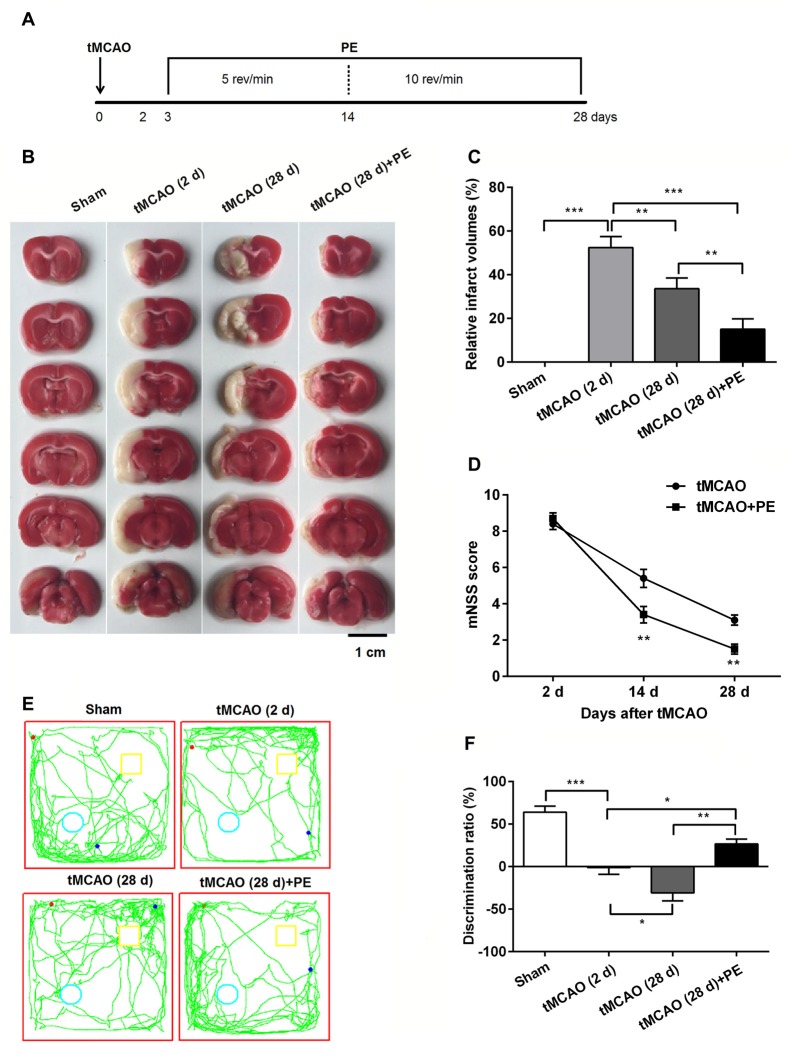
Physical exercise (PE) improves novel object recognition (NOR) memory in transient middle cerebral artery occlusion (tMCAO) rats. (A) Spontaneously hypertensive rats (SHR) were subjected to tMCAO or sham surgery, followed by 26 days of PE starting on day 3 post-tMCAO. Thereafter, infarct volumes were (B) imaged and (C) measured n = 5; (D) neurobehavioral outcomes were evaluated based on modified neurological severity scores (mNSS) n = 20; (E) Exploration patterns were video recorded; green lines are exploring patterns of rats, red dots represent the points where rats were placed in the test room, pale blue circle and yellow square represent two different objects. (F) Discrimination ratios were measured. n = 10; *P < 0.05; **P < 0.01; ***P < 0.001.